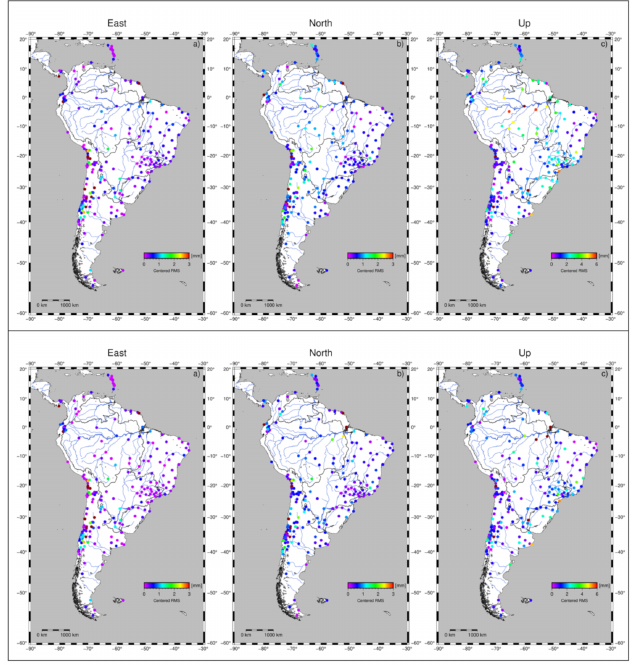
Figure 14. Map of the CRMS (in mm) using GLDAS/Noah hydrology model for the dif- ferent GPS sites and each component, ( a ) East, ( b ) North, and ( c ) Up. Top panel: CRMS for the initial model (ATMMO+GLDAS/Noah). Bottom panel: CRMS for the new model (ATMMO+GLDAS/Noah +